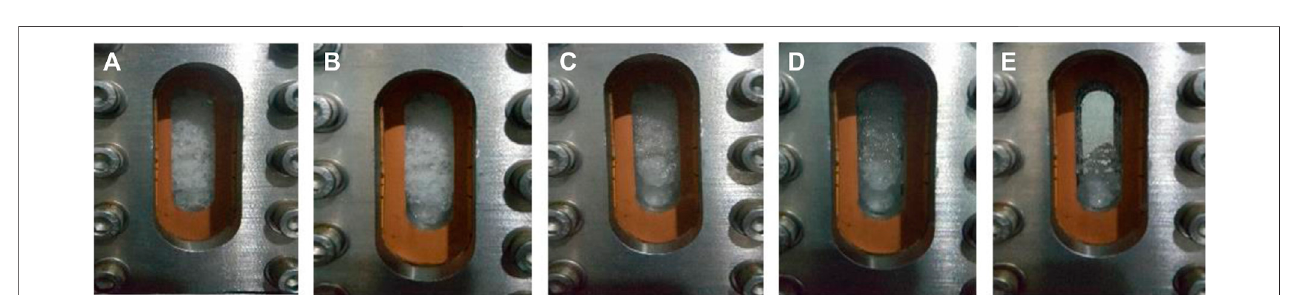
FIGURE 6 | The pictures during replacement process with pure N 2 (A ∼ 0 h, B ∼ 4 h, C ∼ 8 h, D ∼ 12 h, E ∼ 20 h).